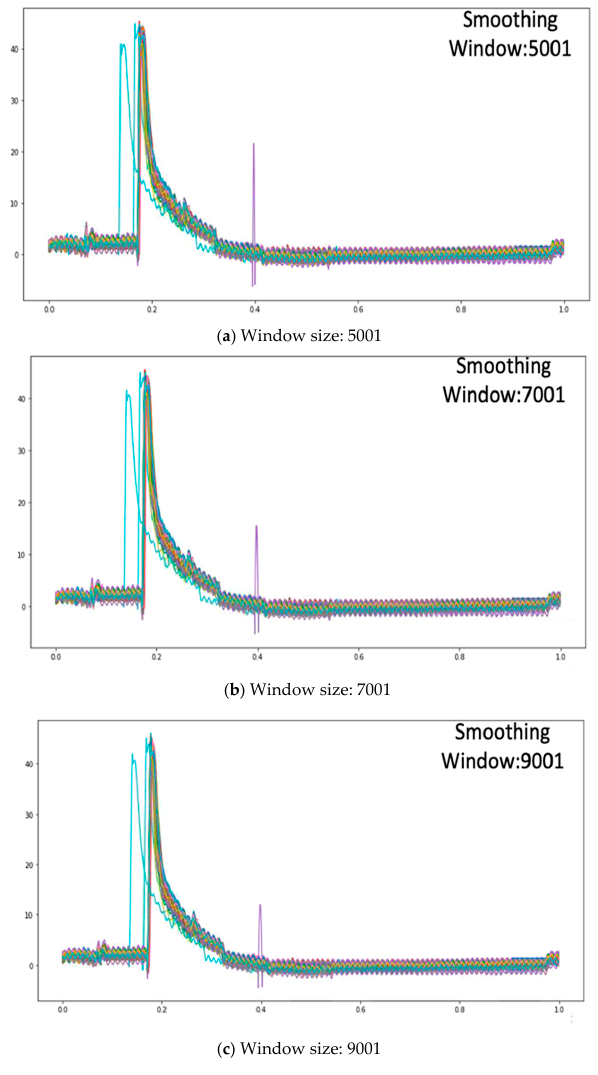
Figure 14. Comparison of Savitzky-Golay Filter smoothing effect by different window size.